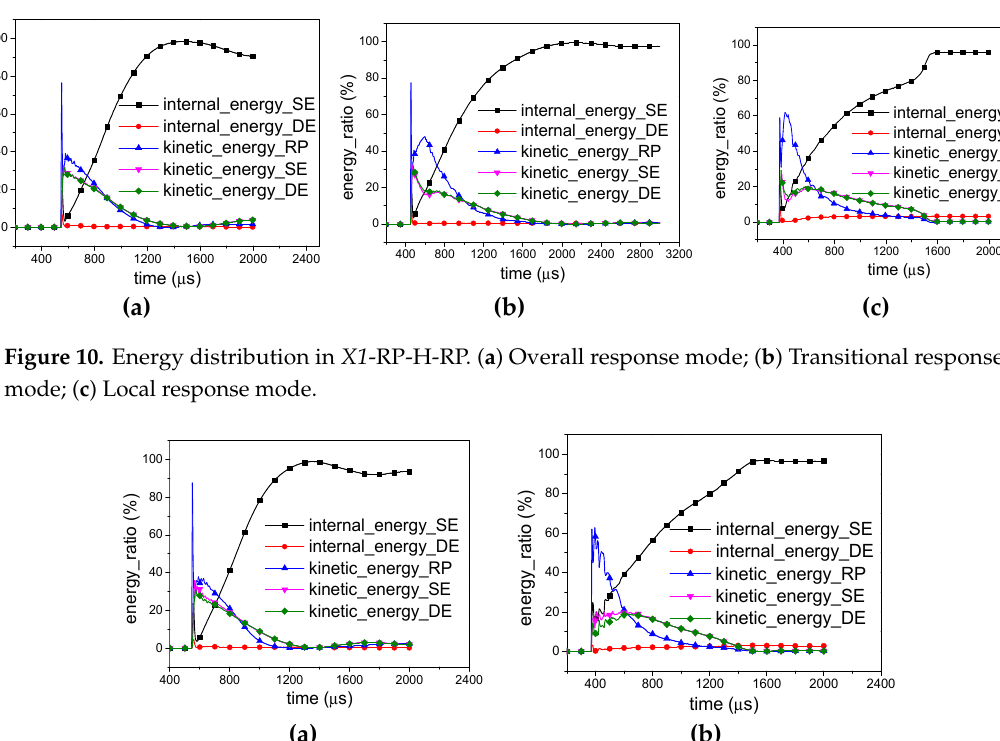
Figure 11. Energy distribution in X2 -RP-H-RP. ( a ) Expansion mode and ( b ) Local inner concave mode.